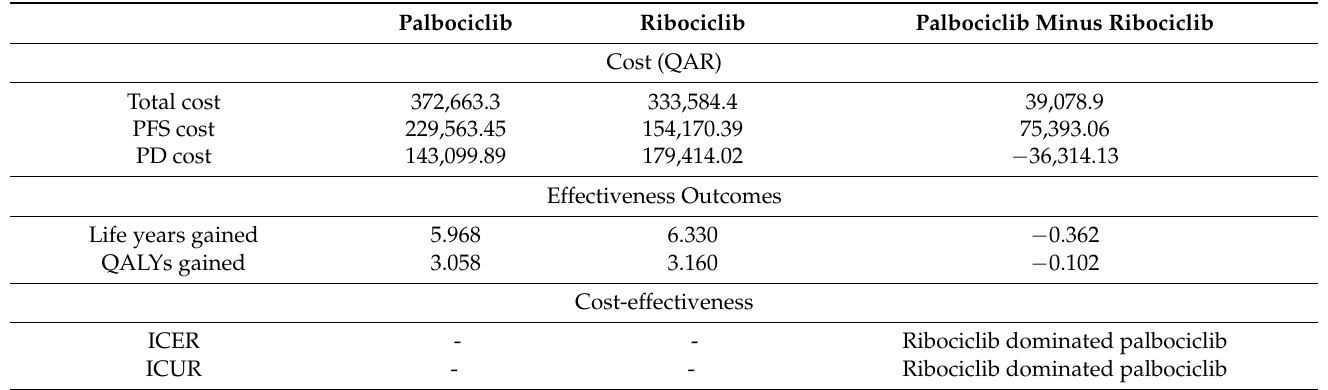
Table 4. Base-case results for palbociclib and ribociclib treatment